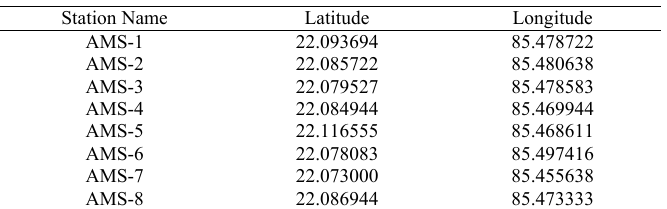
Table 1. Sampling station details